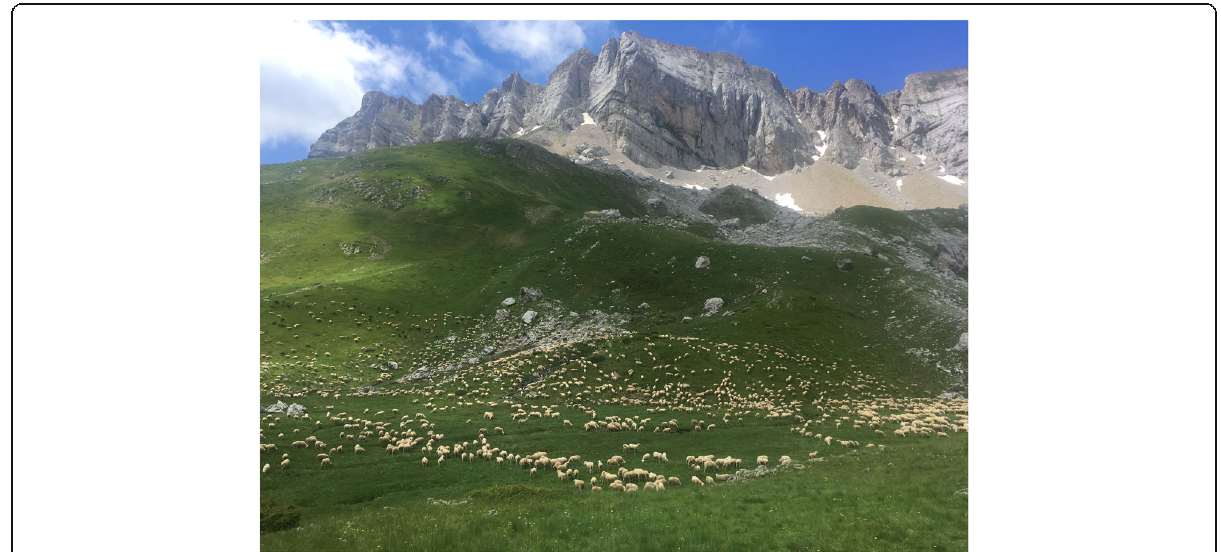
Fig. 1 Sheep grazing in summer pastures in the high